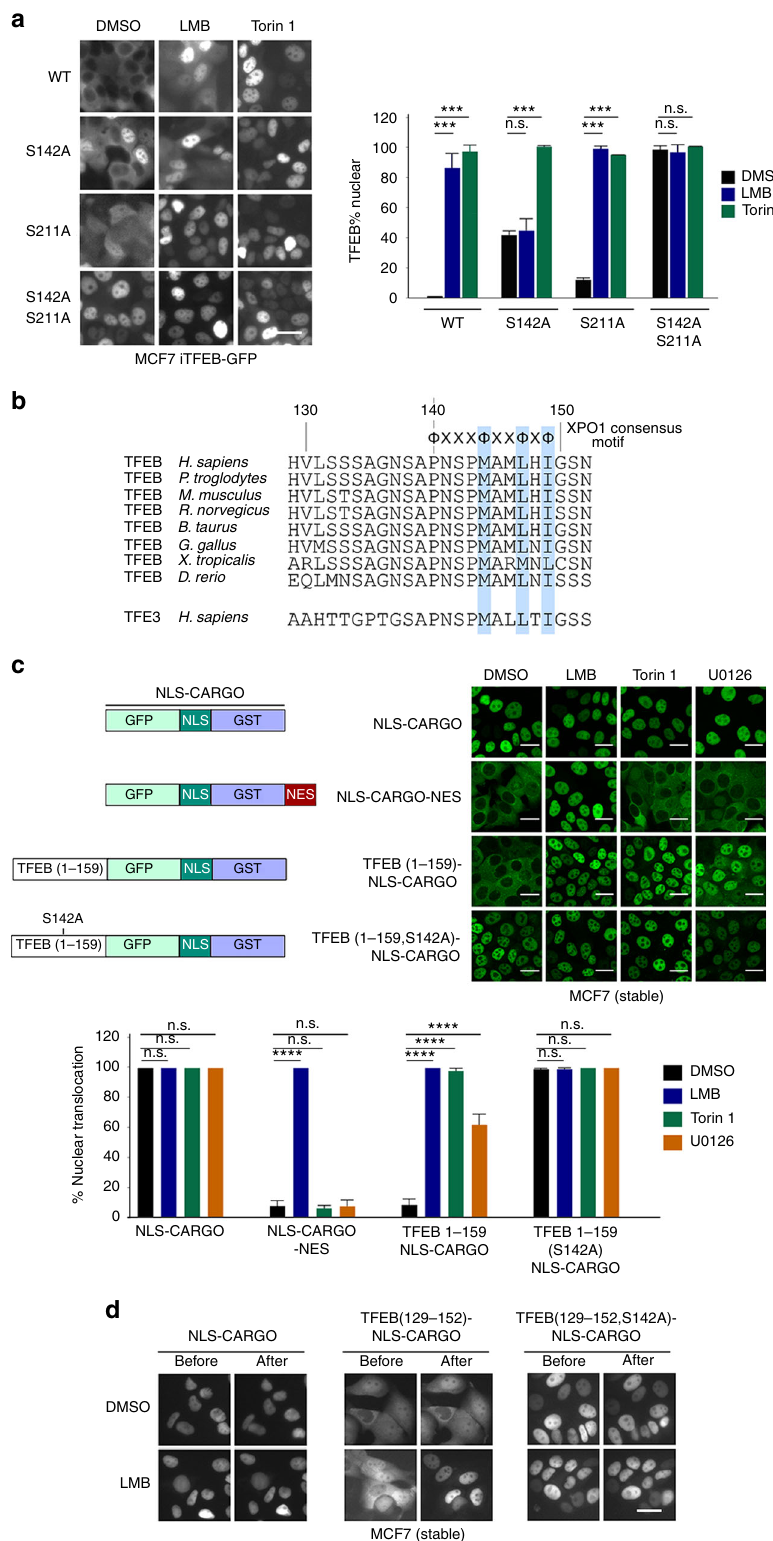
Fig. 2 Identi fi cation of a TFEB nuclear export signal. a Live cell fl uorescence images of indicated WT and mutant TFEB-GFP proteins in stably expressing MCF7 cells. Cells were treated with DMSO, LMB (20nM; 2h) or Torin 1 (20nM; 1h). n >30 cells per condition. b Alignment of TFEB amino acids 129 – 152 and equivalent TFE3 residues. Amino acids highlighted in blue conform to the consensus for an NES. c Live cell fl uorescence imaging of MCF7 cells stable expressing indicated fusion proteins imaged before or after treatment with LMB (2h; 20nM), Torin 1 (1h; 250nM), or U0126 (3h; 20 μ M). Imaging was performed after fi xation. n >50 cells per condition. Error bars = SD. Student ’ s t -test; *** P <0.001, **** P <0.0001, n.s. not signi fi cant. d Real time fl uorescence imaging of MCF7 cells stably expressing the indicated fl uorescent TFEB (129 – 152) cargo vectors before or after treatment with LMB (20nM; 2h). Scale bars = 20 μ